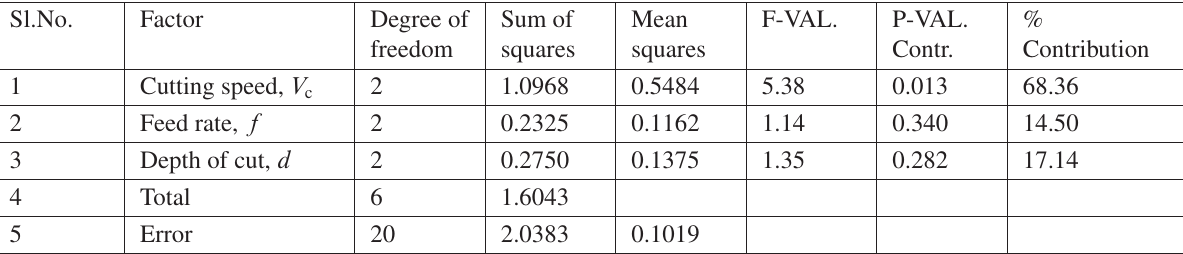
Table 4. ANOVA for surface roughness ( R a ).